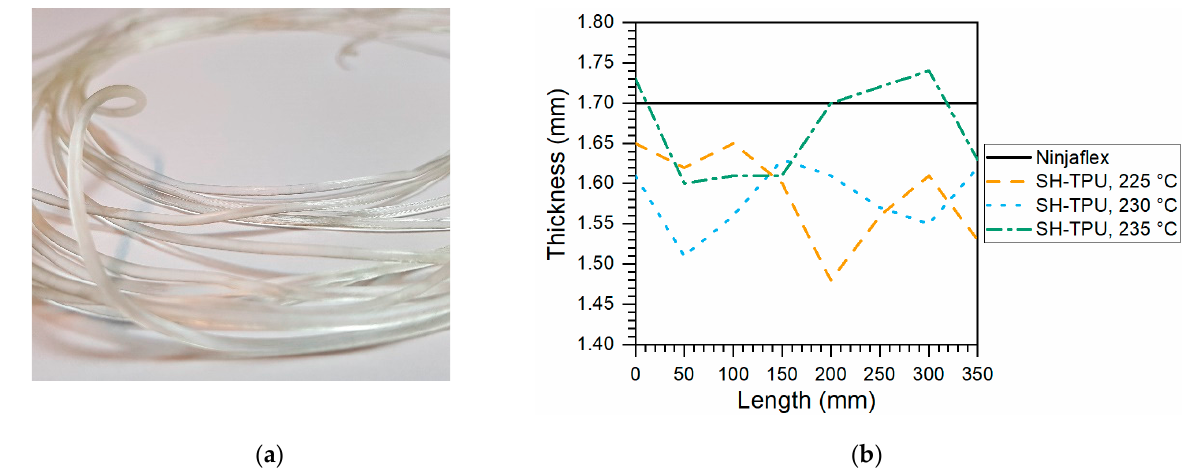
Figure 7. SH-TPU filament making results. ( a ) picture of the extruded SH-TPU filament; ( b ) thickness distribution of the filaments used for printing.